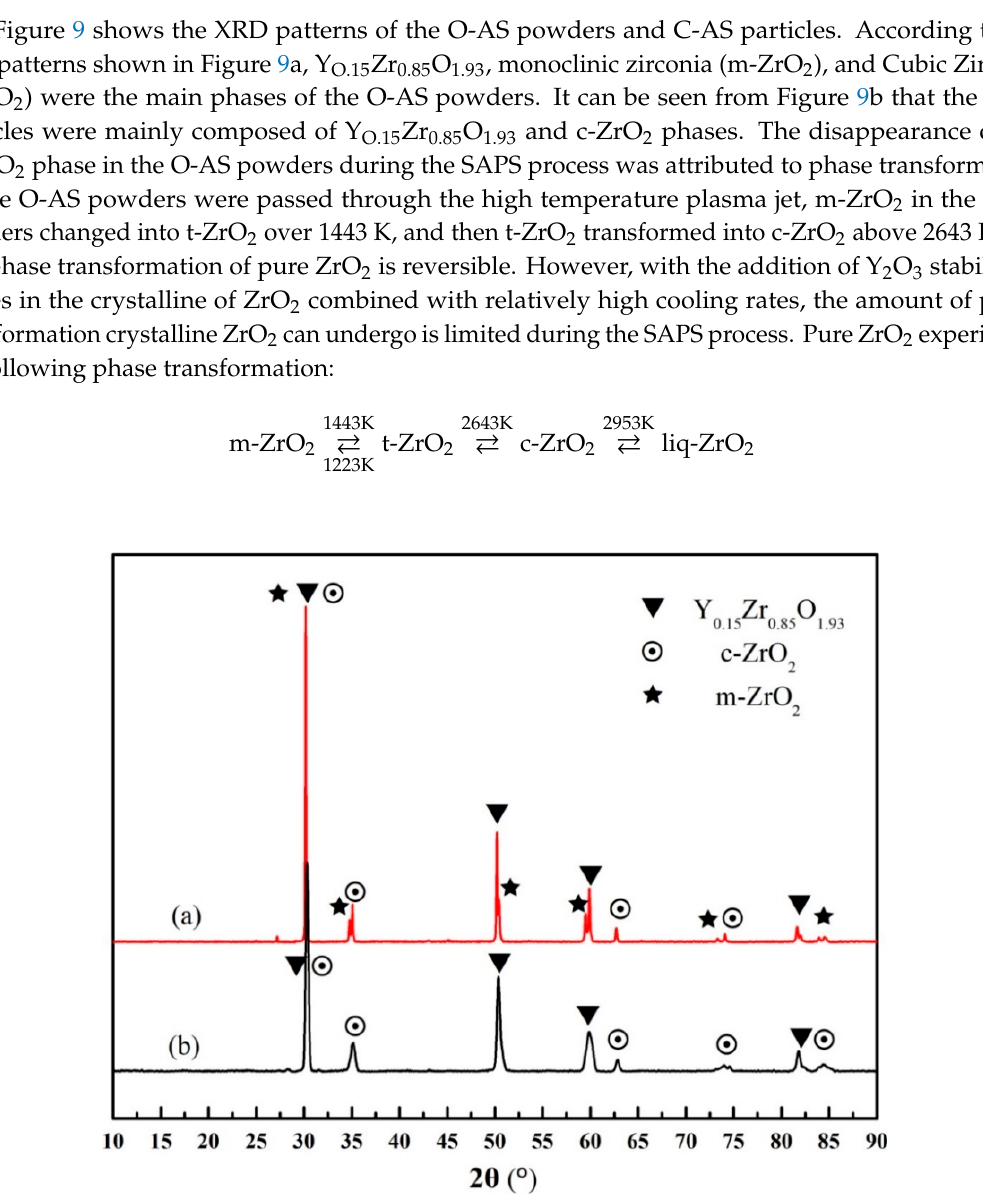
Figure 10. Morphologies of C-AS particles: ( a , b ) surface morphologies; ( c , d ) cross-sectional morphologies.